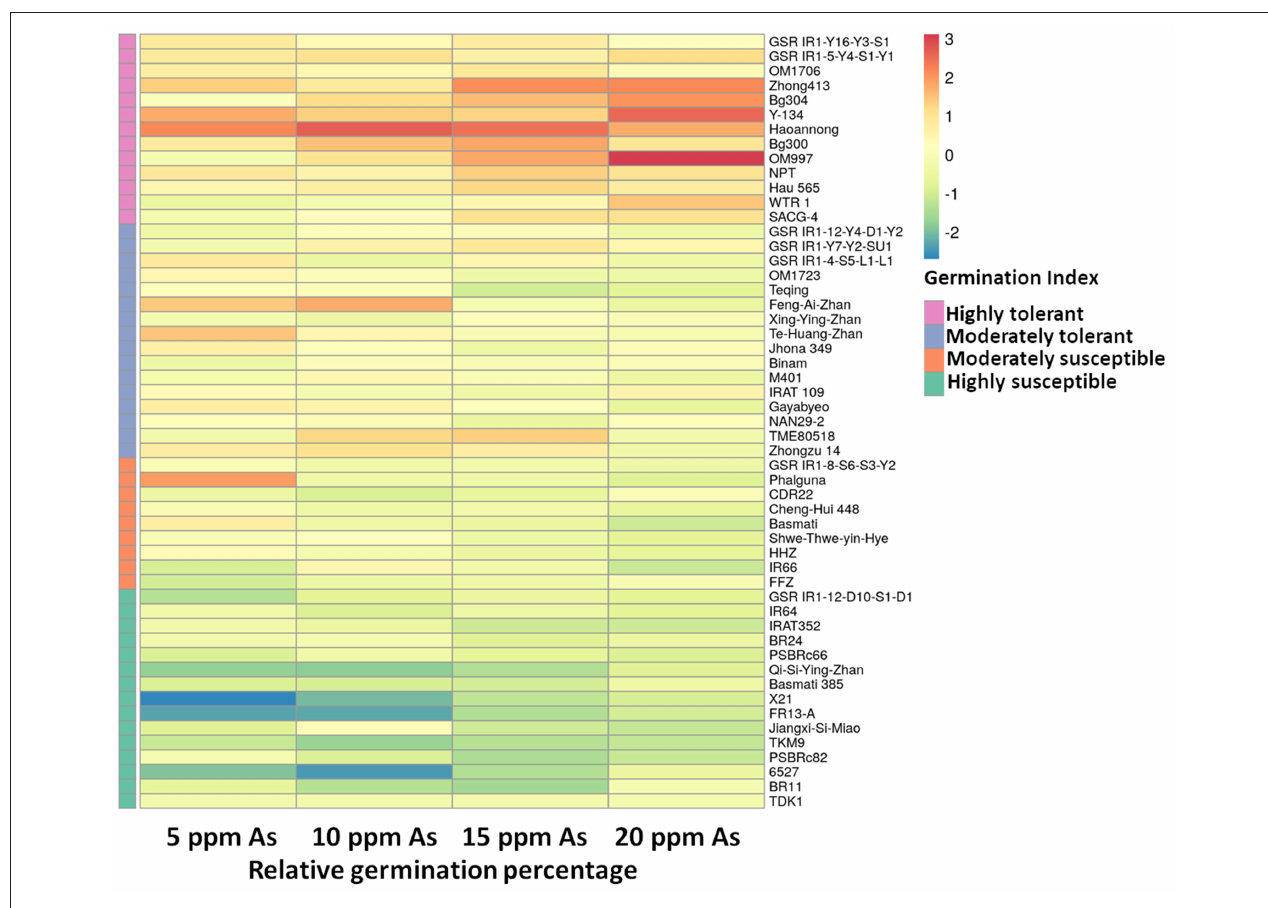
FIGURE 2 | Grouping of 53 different cultivars based on relative germination tolerance under different arsenic stress. As, arsenic; ppm, parts per